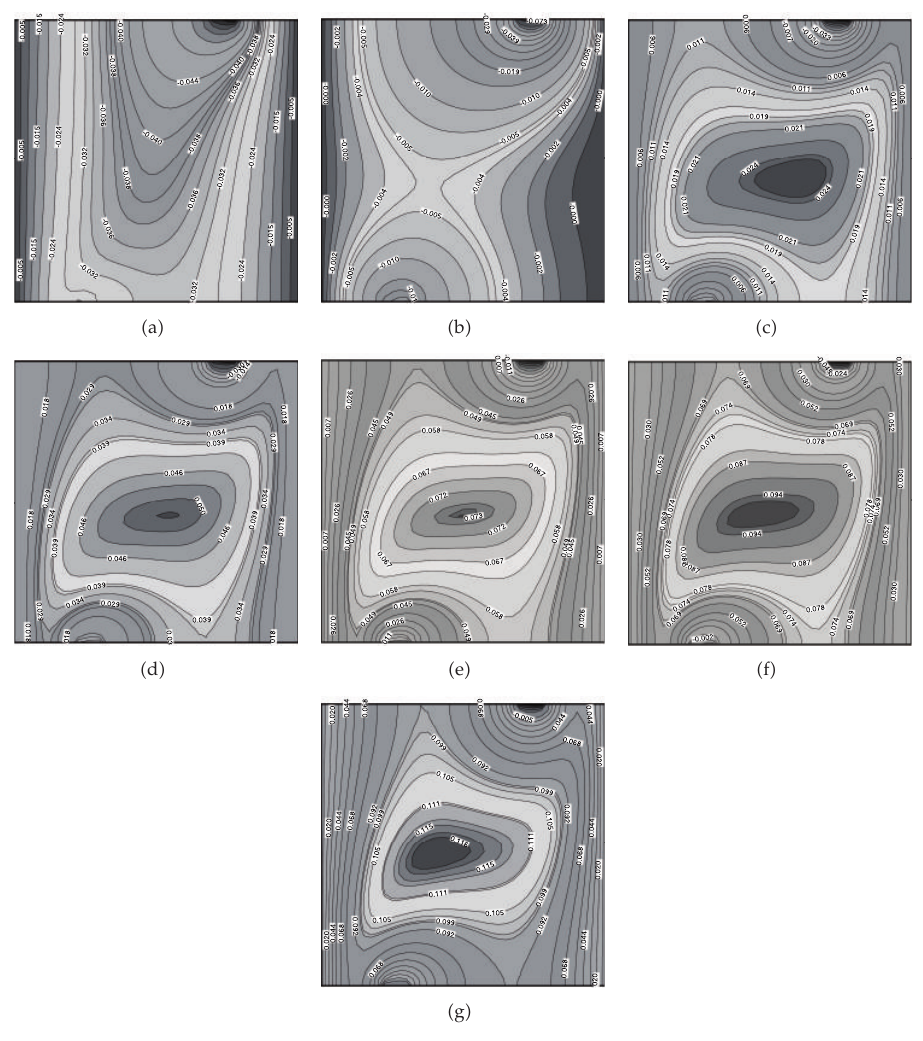
Figure 12: Streamline contours along the left vertical wall while fixing Le (cid:8) 1, D/H (cid:8) 0 . 1, (cid:2) a (cid:3) (cid:8) 0 . 1, Ra (cid:8) 100, S C (cid:8) 0 . 1 for (cid:2) a (cid:3) B (cid:8) − 1 . 5, (cid:2) b (cid:3) B (cid:8) − 1, (cid:2) c (cid:3) B (cid:8) − 0 . 5, (cid:2) d (cid:3) B (cid:8) 0, (cid:2) e (cid:3) B (cid:8) 0 . 5, (cid:2) f (cid:3) B (cid:8) 1, (cid:2) g (cid:3) B (cid:8) 1 .